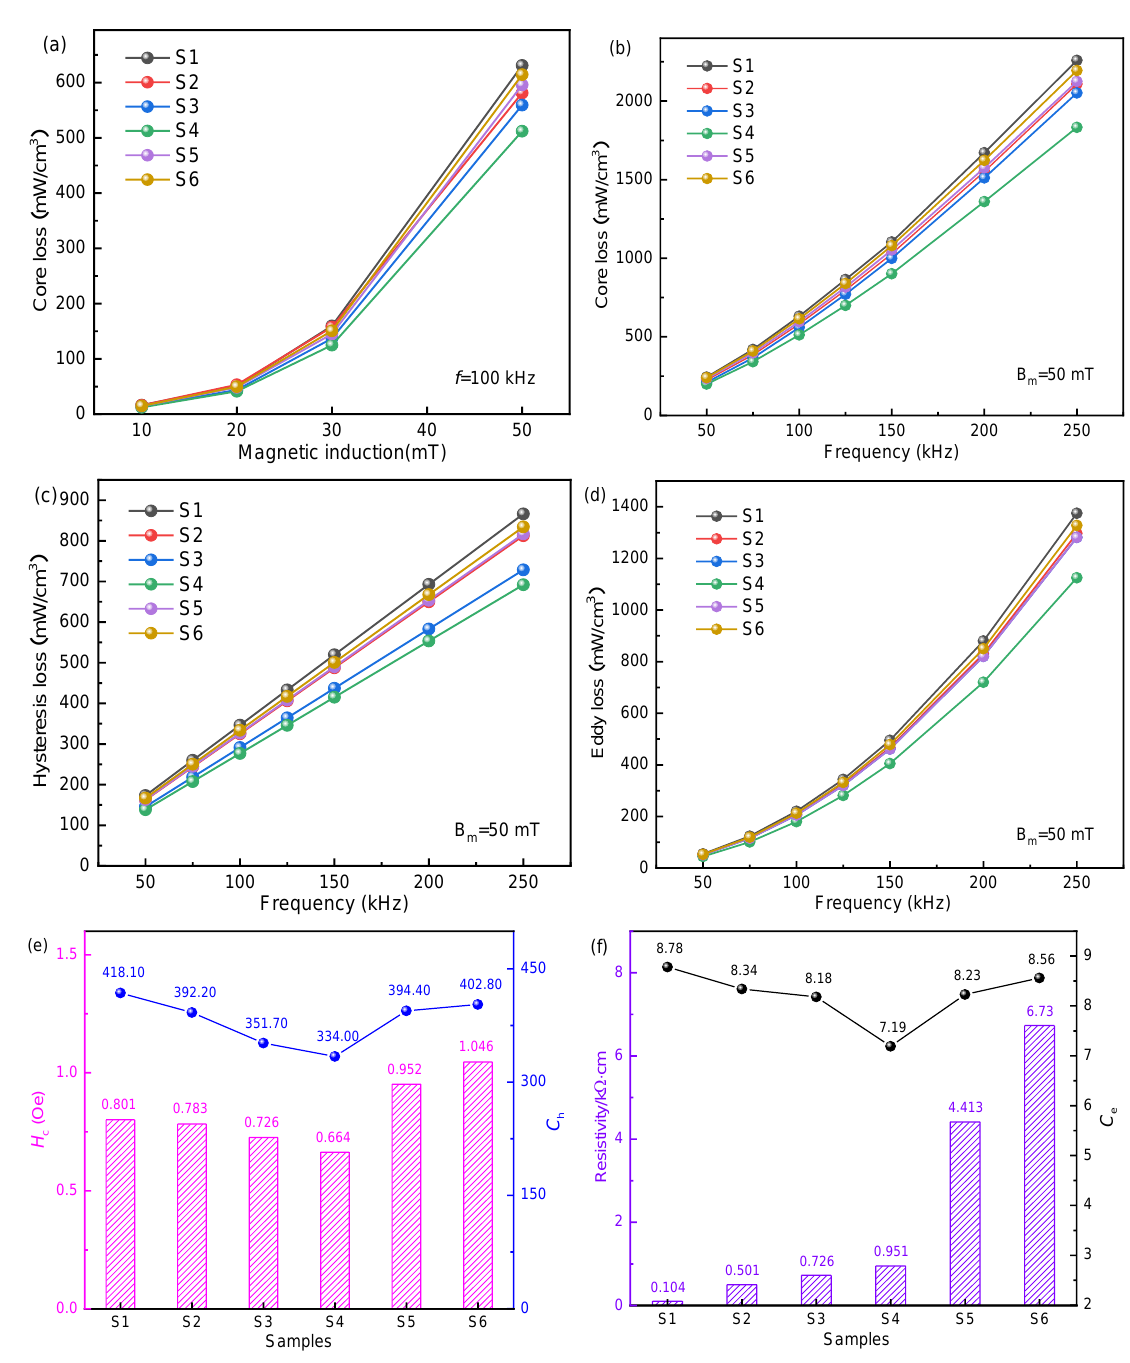
Figure 9. ( a ) Simulation results for frequency dependence of the core losses of S1~S6 under different magnetic induction. P cv ( b ), P h ( c ), and P e ( d ) of FeSiAl@EP SMPCs with different frequencies. ( e ) The coercivity and the coefficient of hysteresis loss of the samples. ( f ) The resistivity and the coefficient of eddy current loss of the samples of S1~S6.